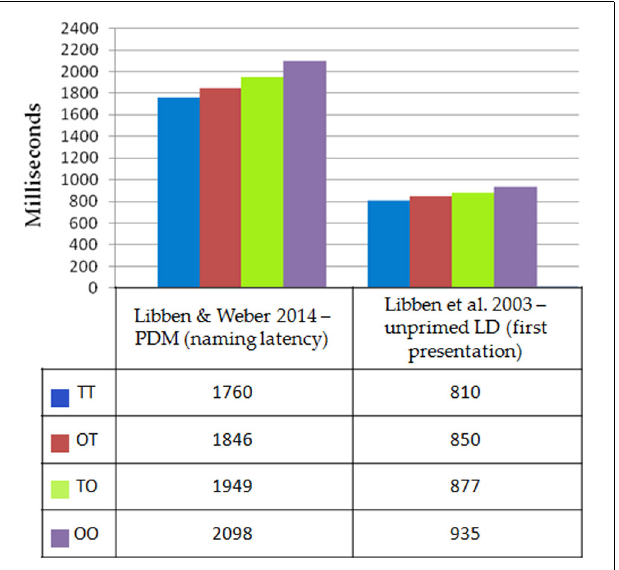
FIGURE 2 | Comparing the progressive demasking results of Libben and Weber (2014) and the lexical decision results of Libben et al. (2003) for four types of compounds: transparent–transparent, TT; opaque–transparent, OT; transparent–opaque, TO; and opaque–opaque,